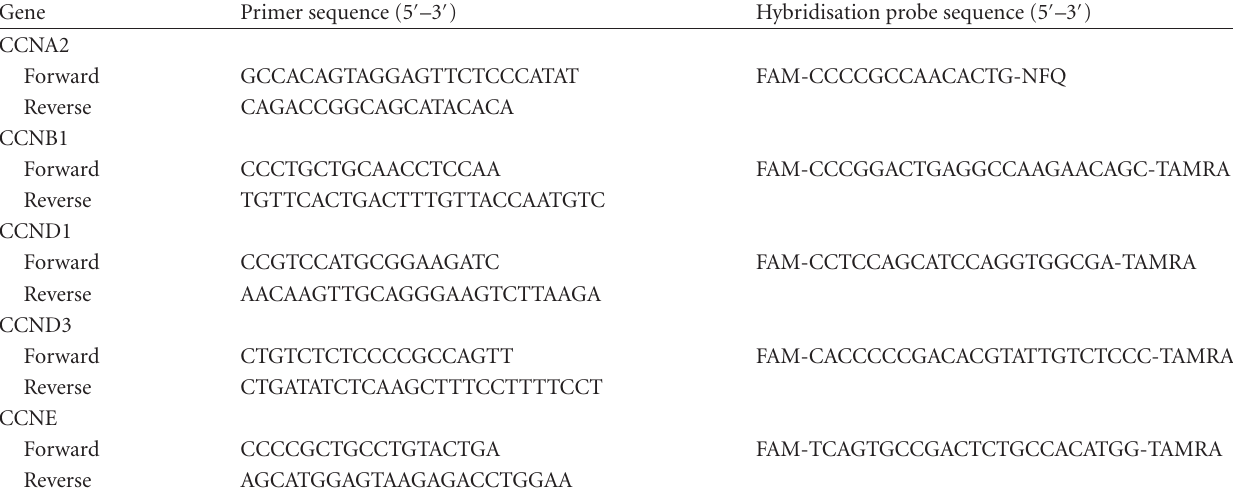
Table 2: Primer and probe sequences for cyclins used in real time quantitative polymerase chain reaction. Gene Primer sequence (5 (cid:4) –3 (cid:4) ) Hybridisation probe sequence (5 (cid:4) –3 (cid:4)